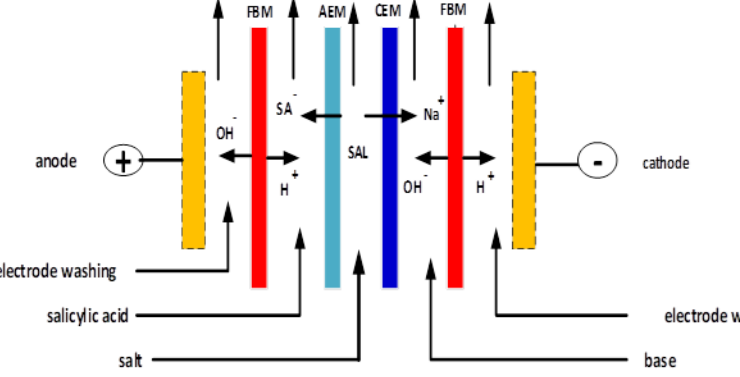
Figure 3. Schematic diagram of an BMED